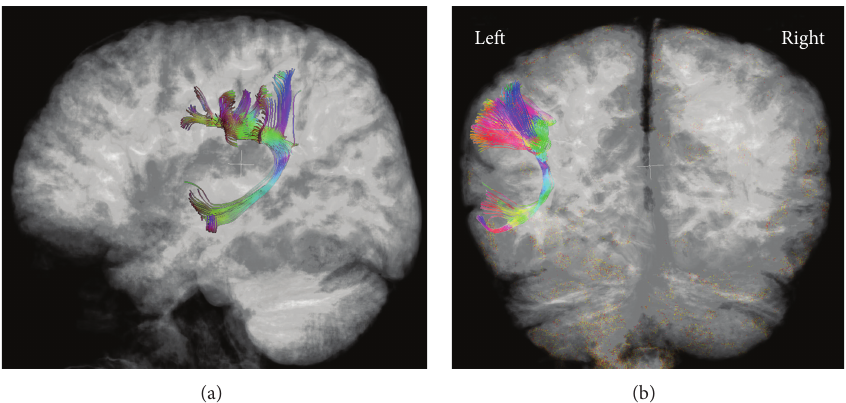
Figure 3: Left lateral (a) and posterior (b) views of the arcuate fasciculus (AF) in a patient with polymicrogyria involving both Broca’s and Wernicke’s areas in the left hemisphere. This right-handed patient had an identifiable left AF and normal language development.